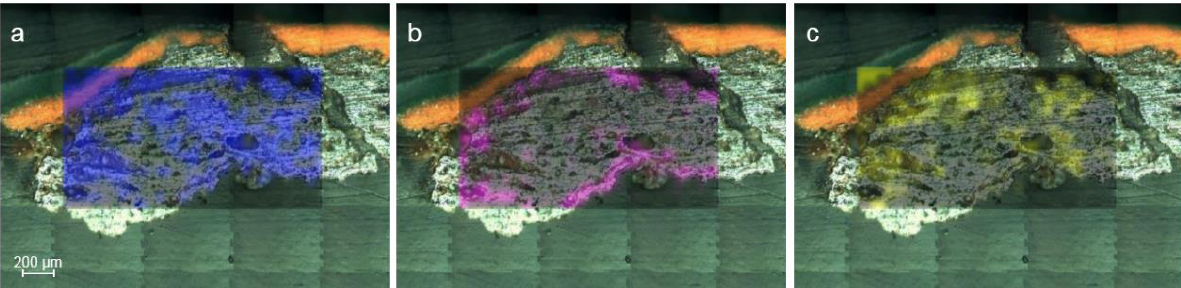
Figure 7. Raman images show the distribution of goethite ( a ), lepidocrocite ( b ), and magnetite ( c ) in the sample SUBS-2a.